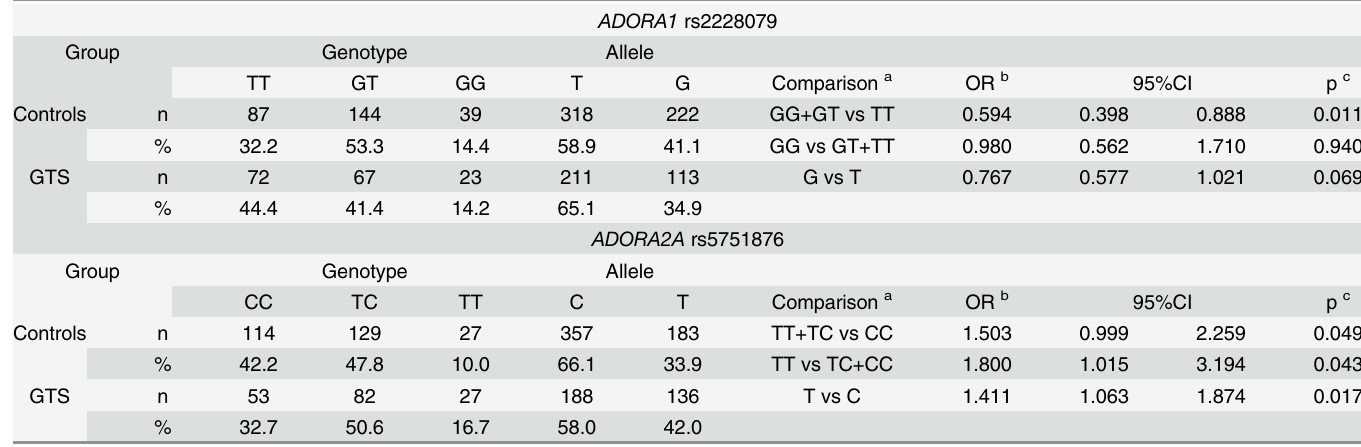
a Comparison of genotype or allele frequencies between the GTS and control groups b OR for the genotype or allele frequencies compared between GTS patients and controls